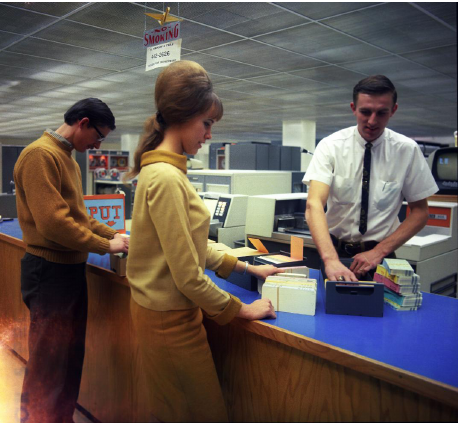
Figure 6. Two programmers (left) submitting their card decks to the operator for reading into the CDC 6600 in about 1970